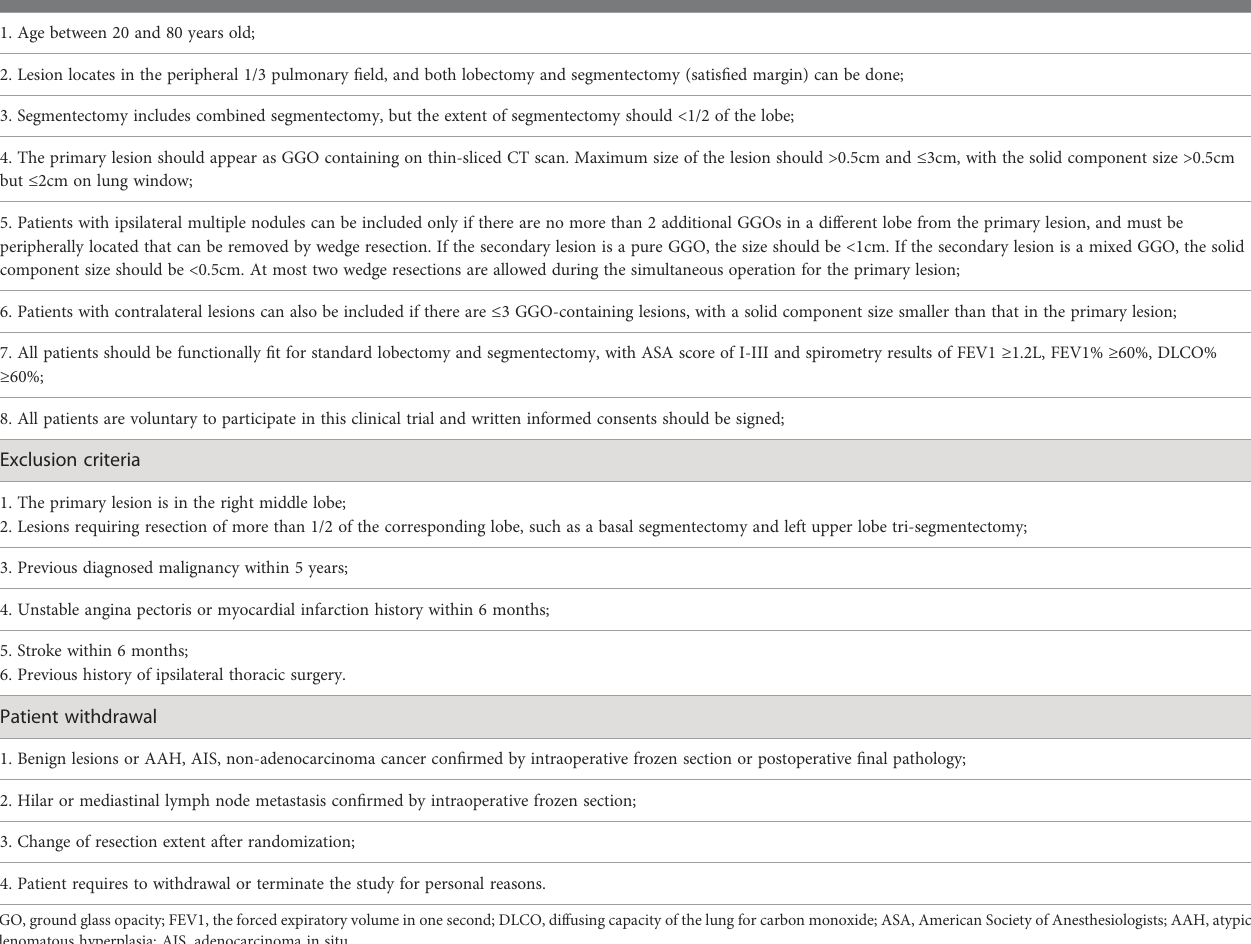
TABLE 1 Patient inclusion and exclusion